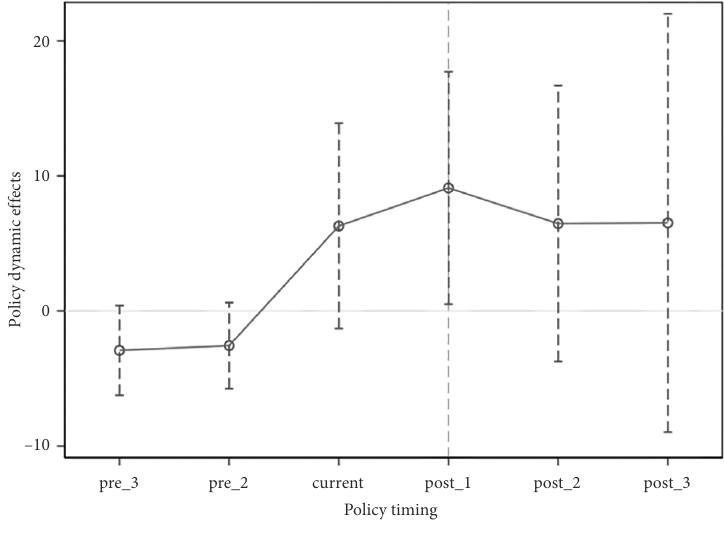
Figure 2. Parallel trend